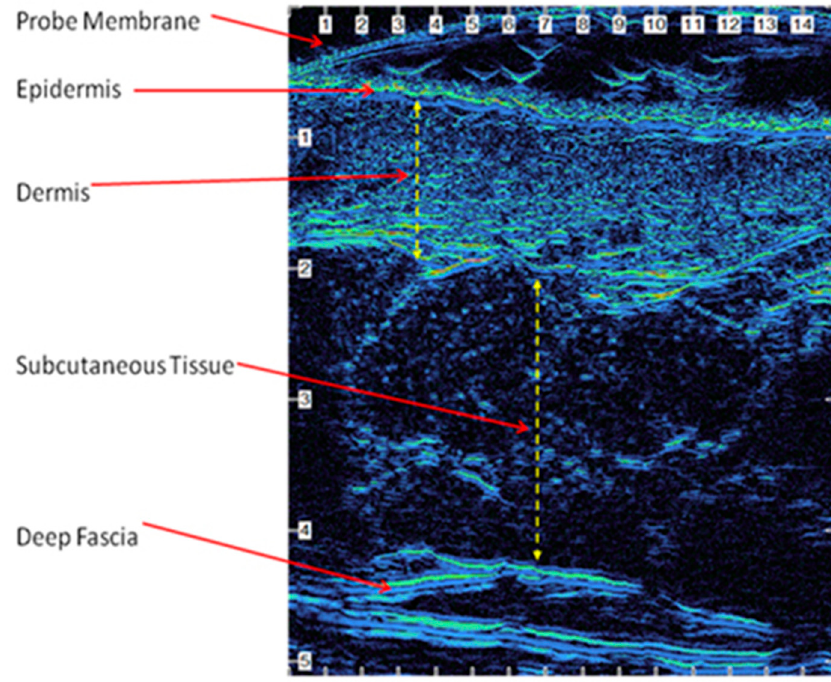
Figure 4. The skin layers at different cross-sections in a high-resolution ultrasound image [13]. Figure 5 shows the average stratum corneum thickness at the different skin sites with In this experiment, a sample of 605 color images was obtained from eight different +1 sigma and − 1 sigma. areas of the body: the arm, cheek, chin, eyelid, forehead, lips, neck and nose. Table 3 shows the skin layers’ thickness measured at the different skin sites. The re- sults show that the cheek contains the highest percentage of dermis among all facial sites, about 95.3%, while the neck’s dermis percentage was the lowest at 92.0%. The value for the stratum corneum was found to be highest on the chin, at 0.038 mm, and lowest on the arm—merely 0.024 mm. Likewise, the epidermis thickness measurements recorded for the arm and chin were lowest (0.047 mm) and highest (0.083 mm), respectively. A deviation from the mean indicates poor skin condition. The risk of skin damage will be higher when the standard deviation is high. Table 3. The measured skin layer thickness of different volunteers at the different skin sites. Skin Sites Count 1 Full Skin